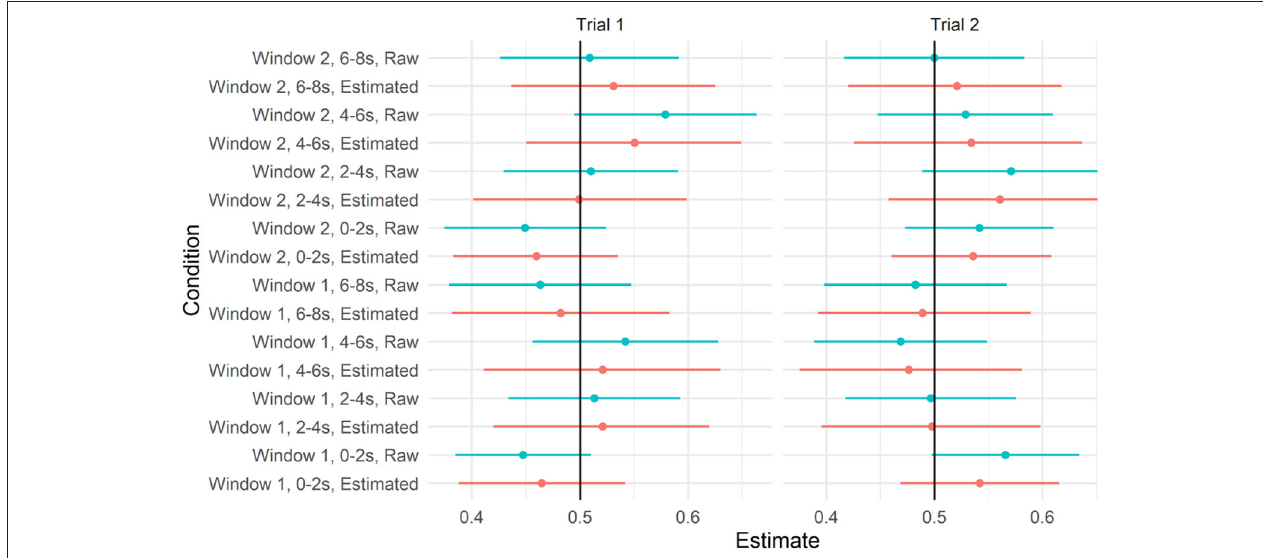
FIGURE 7 | Predicted values from the model testing the interaction between trial, window, and time bin and 95% credible intervals. Raw means and 95% CIs are plotted alongside for reference.